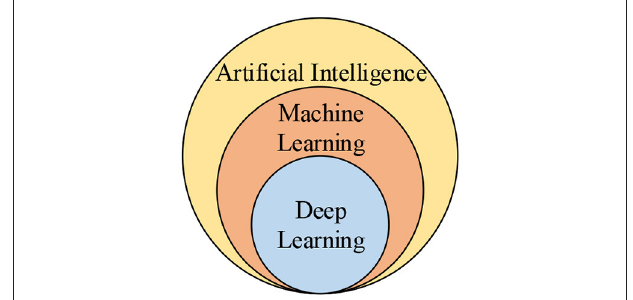
FIGURE 1 | AI vs. ML vs.